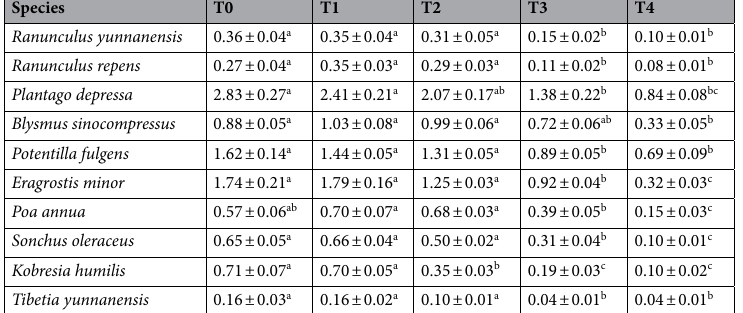
Table 2. Effects of trampling disturbance on leaf area (mean ± SE) of individual plant species. T0, T1, T2, T3, T4 and T5 represents experimental lanes receiving 0, 25, 75, 250 and 500 trampling passes, respectively. Different letters indicate statistically significant difference at p <